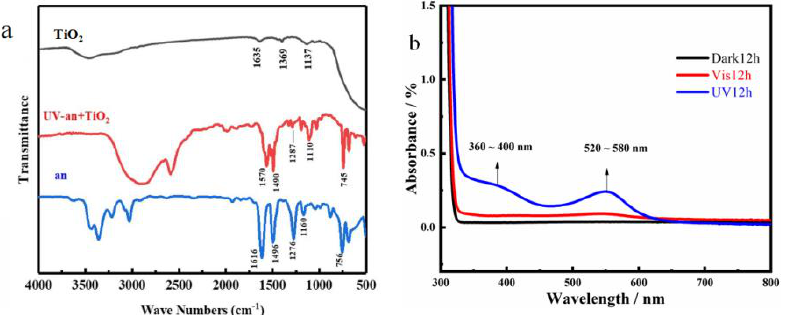
Figure 4. Structural analysis of PANI under different photopolymerization conditions: ( a ) FT-IR spectra and ( b ) UV spectra.